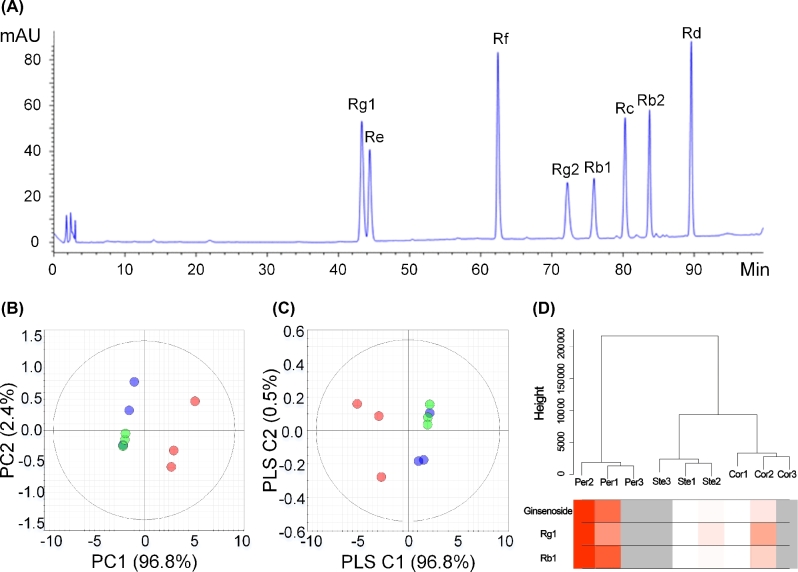
Metabolism and transcriptome analysis of P. ginseng root. (a) HPLC chromatograms of the ginsenosides Rg1, Re, Rf, Rg2, Rb1, Rc, Rb2, and Rd standards. (b) PCA score plots based on the HPLC dataset (red circles indicate periderm, black circles indicate cortex, and green circles indicate stele). (c) PLS-DA score plots based on the HPLC dataset. (d) Cluster tree of the ginseng samples based on the expression pattern of 42 006 genes. The leaves of the tree correspond to the different ginseng tissue samples (Per: periderm; Cor: cortex; Ste: stele). The color bands beneath the tree represent the relative content of the total ginsenosides, Rb1 and Rg1 (red indicates high values).